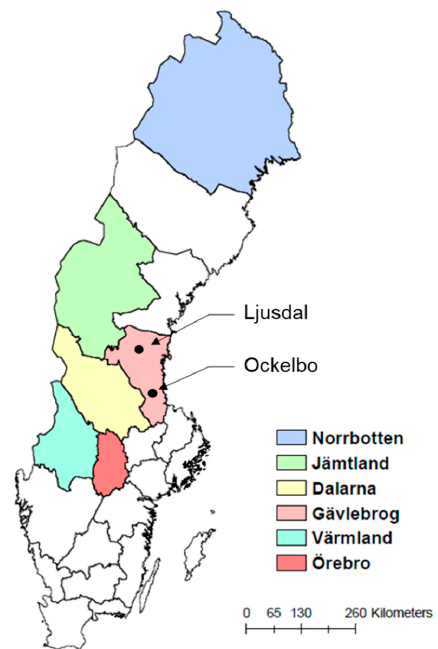
Figure 1. Six counties in Sweden, which fully or partly cover previously-identified high-risk sites for tularemia, and are the cases for future disease projections in the present